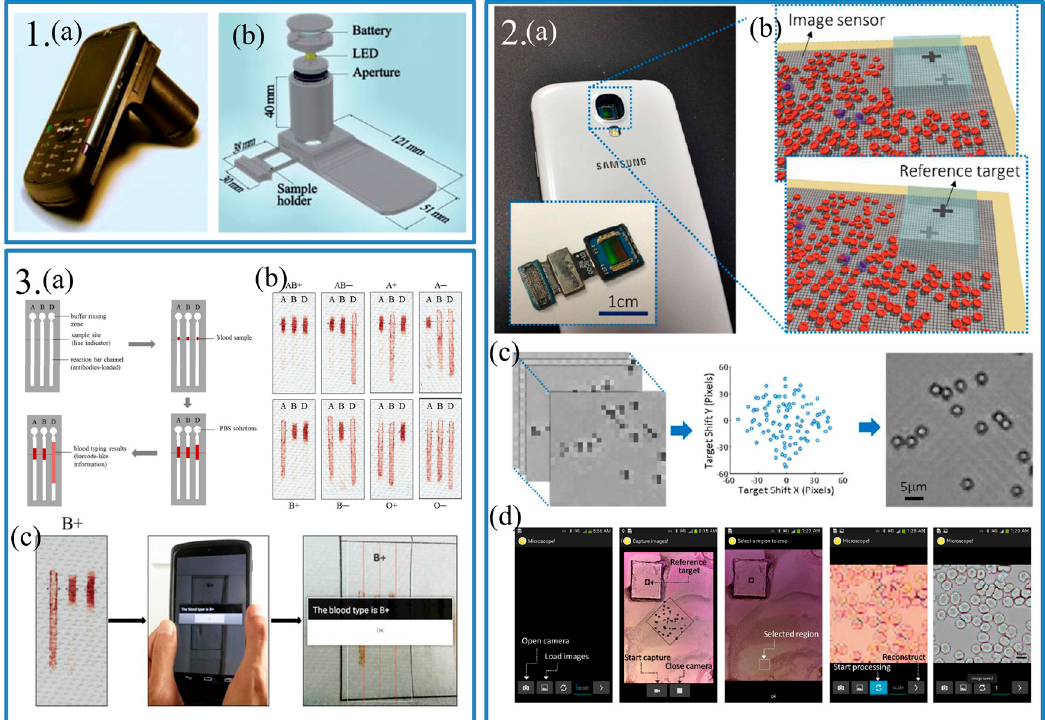
Figure 2. Panel 1: ( a ) The photograph of the lens-free smartphone microscope; ( b ) Schematic diagram of the microscope attachment shown in ( a ). Reproduced from [27]. Panel 2: ( a ) The photograph of the prototype device which was an Android smartphone with the lens module of the camera removed. The inset showed the image sensor module with the lens removed; ( b ) The working mechanism of the smartphone-based microscope. The shadow of a reference target and samples in different angle were traced when the user tilts the device around; ( c ) The reconstructed process took placed in the smartphone. 100 raw images ( Left ) were taken to get a reconstructed image ( Right ); ( d ) Imaging process of with the custom-built application. From left to right: starting to capture images or load images, capturing images, selecting a region to reconstruct, starting processing of reconstruction, viewing result and saving. Reproduced from [28]. Panel 3: ( a ) A schematic diagram of the barcode-like blood typing device. Along the arrow: introducing the antibodies into the reaction bar channels, introducing the blood sample into the reaction region, eluting the channels with PBS solutions, reading the blood typing test results; ( b ) The actual assays of all eight ABO/RhD blood types by the optimized barcode-like paper based blood typing device; ( c ) Process of the smartphone-based blood typing device. Along the arrow: getting the blood typing test result (B+), reading the result using an Android application, obtaining the blood result with text on the screen. Reproduced from [29].